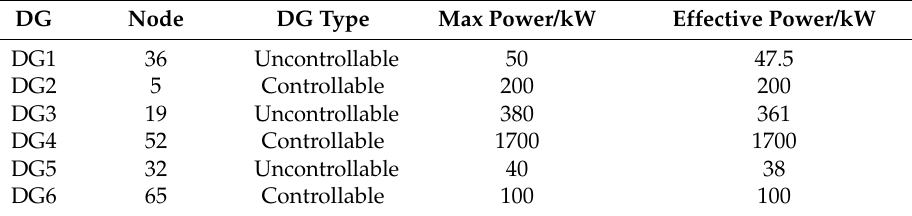
Figure 3. Structure of a PG and E 69-node system. Table 1. Parameters of DGs.